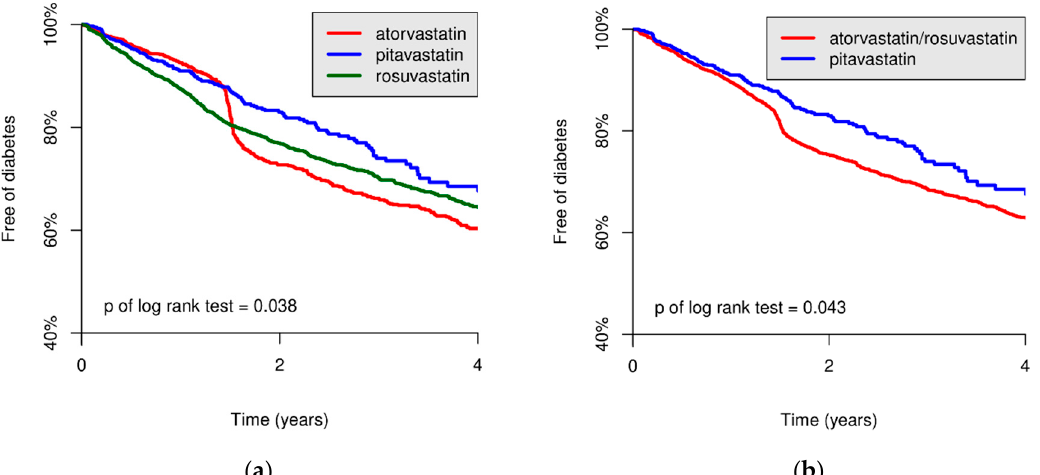
Figure 2. Kaplan–Meier plot of three statin groups for new-onset diabetes mellitus (NODM)-free probabilities curve. The NODM-free probabilities were significantly higher in the pitavastatin group than in the atorvastatin and rosuvastatin groups (log-rank test: p = 0.038) ( a ) and the group of combined atorvastatin and rosuvastatin (log-rank test: p = 0.043) ( b ).